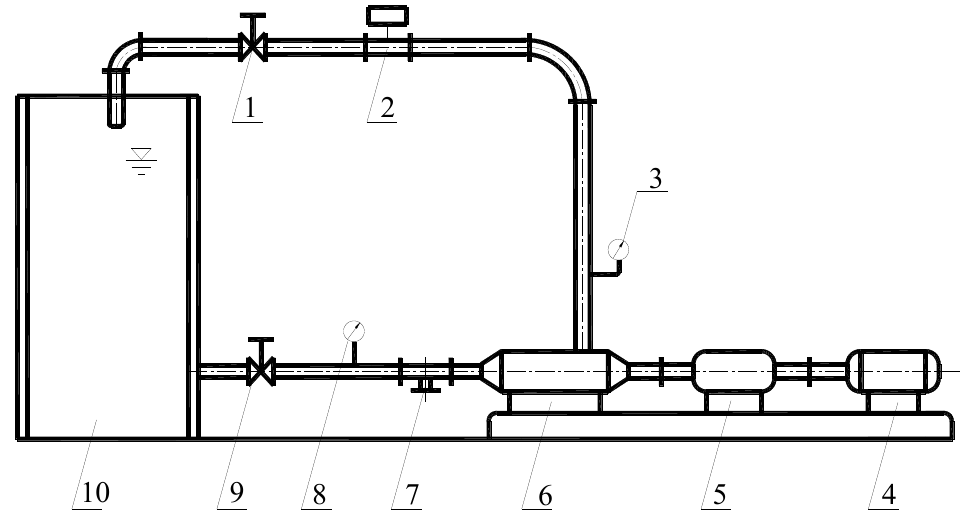
Figure 1. Schematic diagram of the experimental rig. 1: regulating valve; 2: turbine flowmeter; 3: